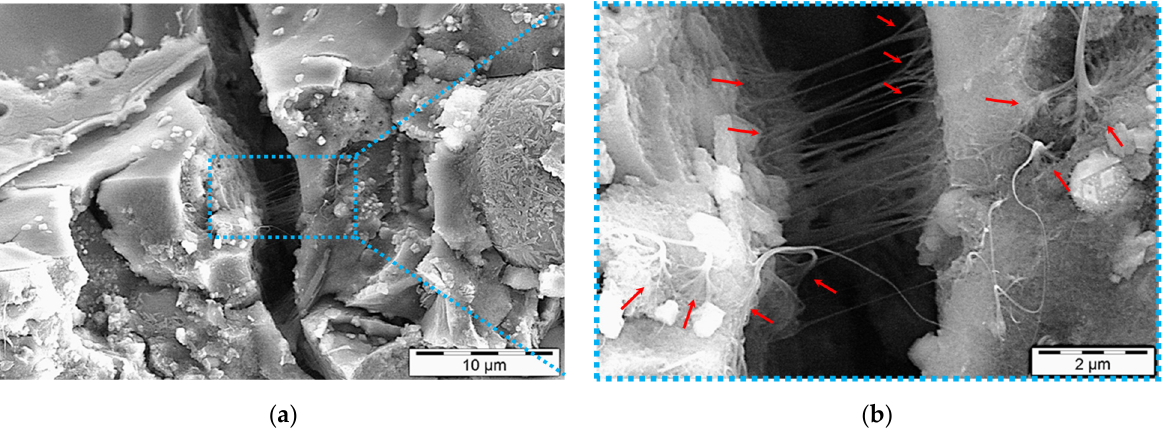
Figure 9. Multifunctionality of 28-day one-part SWCNT-alkali-activated nanocomposites: Integrated SWCNT electrical conductivity and mechanical reinforcement, SWCNT conc. 1.0 wt.%. Manifold configurations of SWCNTs are shown with red arrows. ( b ) is the higher magnification of the selected zone in ( a ), shown by a dot blue box.